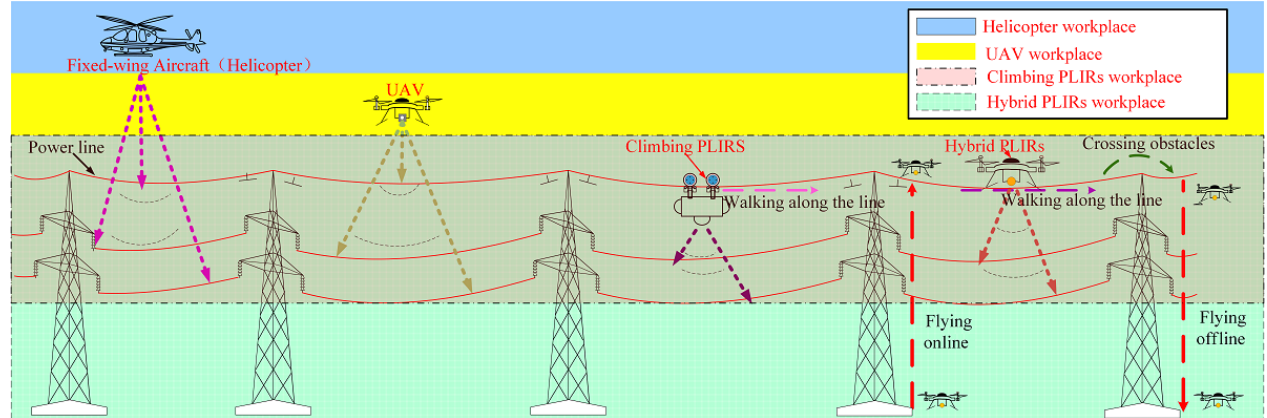
Figure 1. Illustration of the workspace of the different PLIRs.